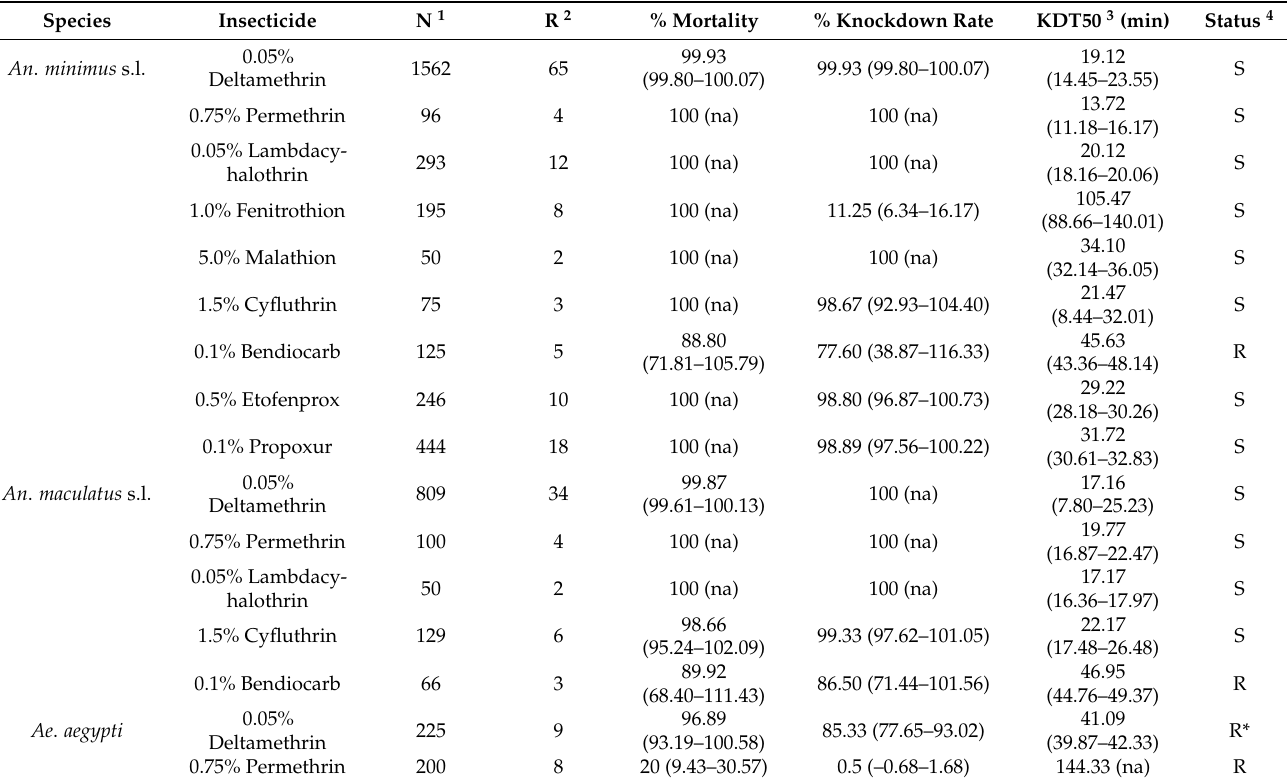
Figure 3. In F1 Ae. aegypti , suspected resistance to deltamethrin (mortality 96.89%) and resistance to permethrin (mortality 20%) was found. The KDT50 values for deltamethrin and permethrin were 41.09 and 144.33 min, respectively. Table 1. Summary results of WHO bioassay tested in An. minimus s.l., An. maculatus s.l., and Ae. aegypti in Suan Oi (SO).